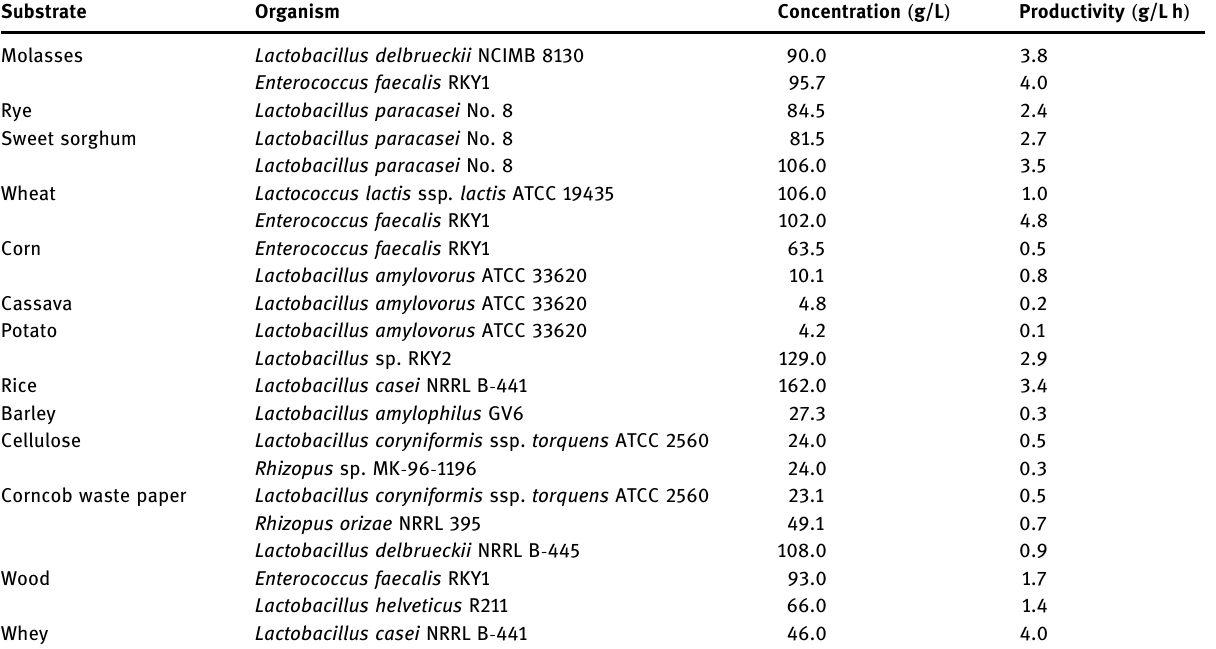
Table 2: Examples of cheap and popular waste material for feedstock application in producing lactic acid biotechnologically [ 83 ]